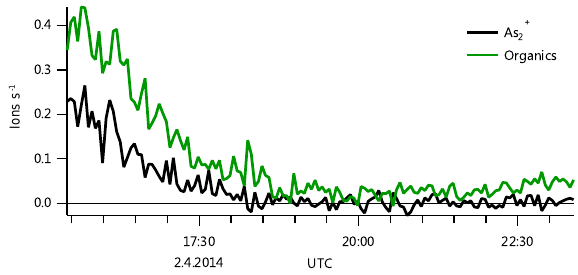
Figure 14. Time series of the mass loadings calculated from peak fitting for the isobaric peaks at 150Th. The organics trace represents the sum of the signals from the peaks C 4 H 6 O + and C 10 H 14 O + 6